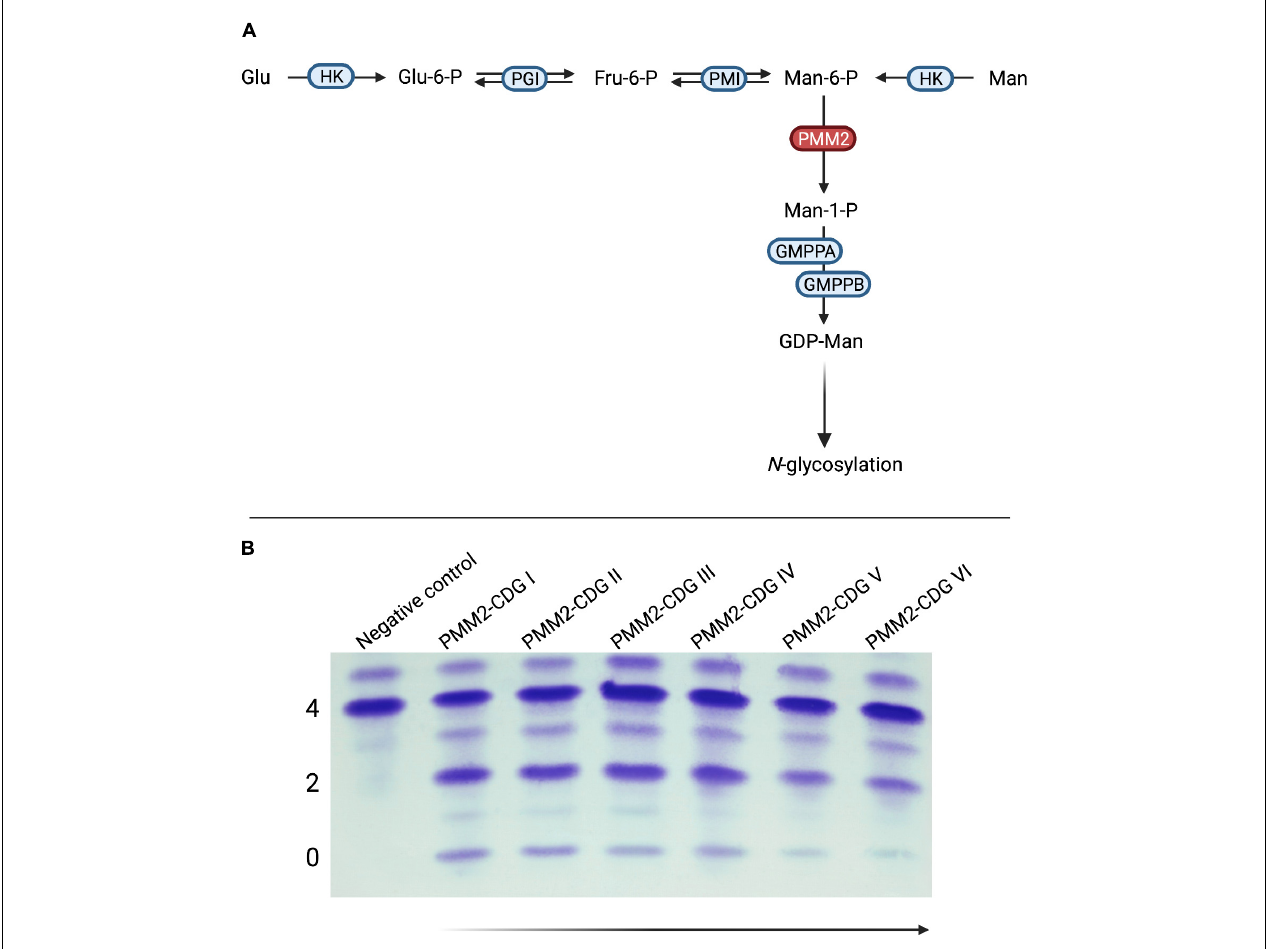
FIGURE 5 | Mannose supplementation in PMM2-CDG. (A) In PMM2-CDG, the conversion of mannose-6-phosphate (Man-6-P) to mannose-1-phosphate (Man-1-P) by phosphomannomutase 2 (PMM2) is impaired due to mutations in PMM2. (B) Findings for mannose supplementation in PMM2-CDG have been inconsistent. In a subgroup of patients, significant improvement of serum transferrin glycosylation can be achieved with oral supplementation of mannose. Of note, these changes occur after several months or even years and have been shown to be reversible if mannose substitution is discontinued. PMM2-CDG I and II – Pretherapeutic samples from the same patient; PMM2-CDG III–VI – Samples after 1, 2, 3, and 4 years of mannose substitution at a dose of 1 g/kg bodyweight/day (HK, hexokinase; Glu-6-P, glucose-6-phosphate; PGI, glucose-6-phosphate isomerase; Fru-6-P, fructose-6-phosphate; PMI, phosphomannose isomerase; GMPPA, Mannose-1-phosphate guanyltransferase alpha; GMPPB, Mannose-1-phosphate guanyltransferase